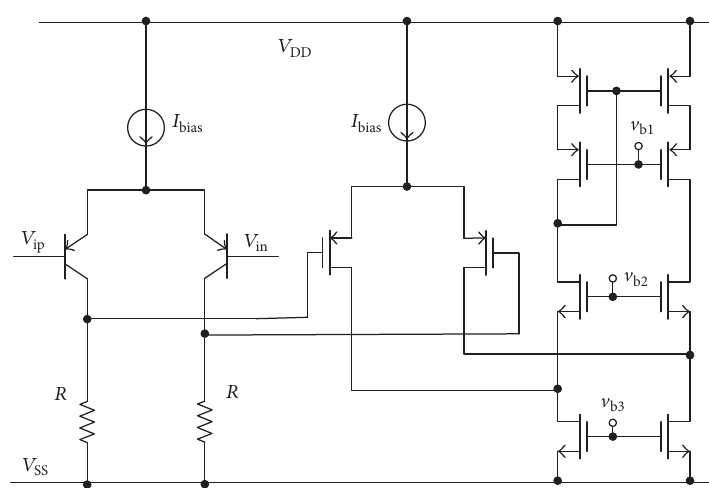
Figure 4: Low-offset operational amplifier circuit.